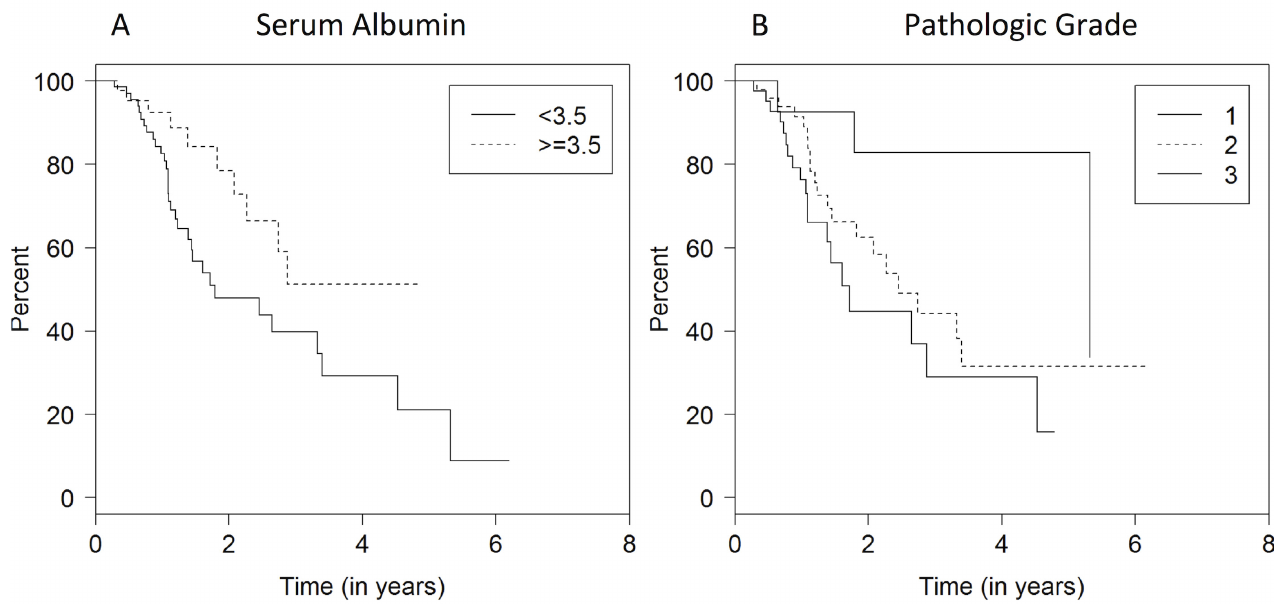
Fig 2. Predictors of increased mortality, SA and histologic grade. (A). Overall survival of patients with SA < 3.5 vs those with SA (cid:3) 3.5. (B) Overall Survival of Histologic Grade utilizing three tier grading (1: well differentiated, 2: intermediate differentiation, 3: poorly differentiated).